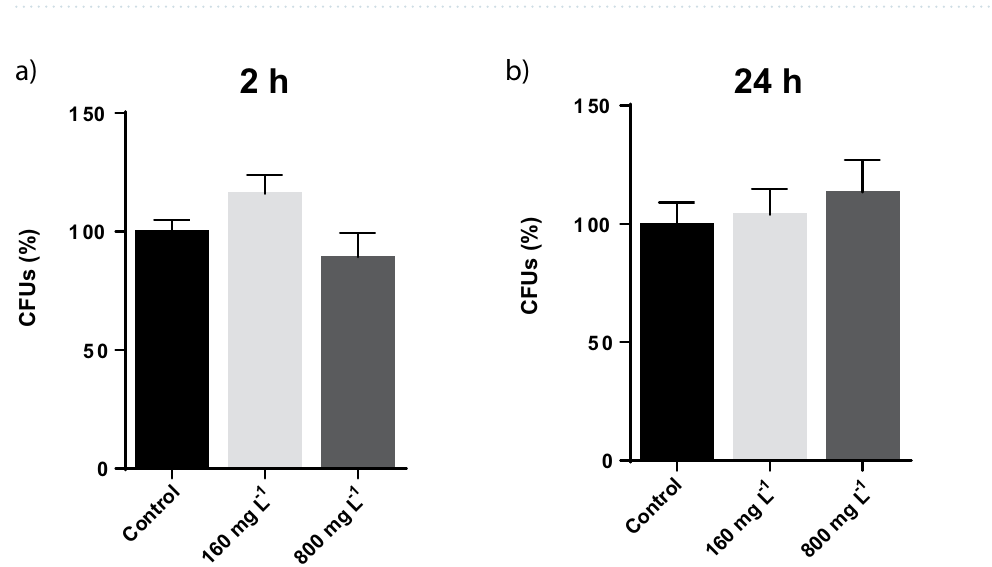
Figure 1. Colony forming units (CFUs) determination of S. cerevisiae cells exposed to 160 and 800 mg L − 1 of GN during 2 hours ( a ) and 24 hours ( b ). The control condition corresponds to non-exposed S. cerevisiae cells. The reported values are the averages of three biological replicates per culture